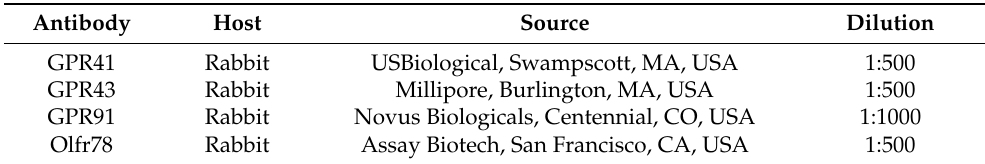
Table 4. Antibodies used for Western